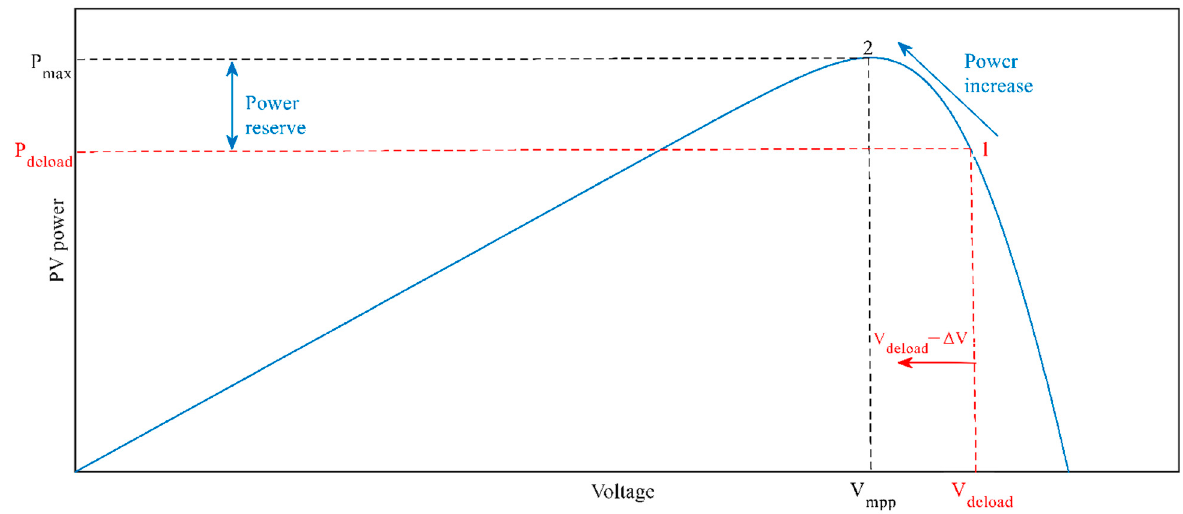
Figure 12. PV deloading process.